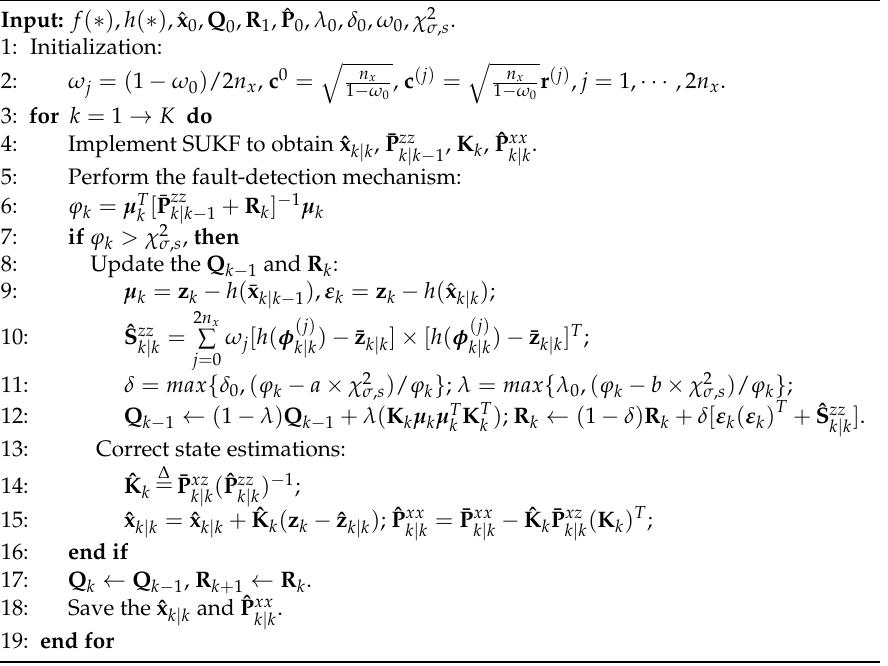
Algorithm 1. The robust adaptive unscented Kalman filter (RAUKF)